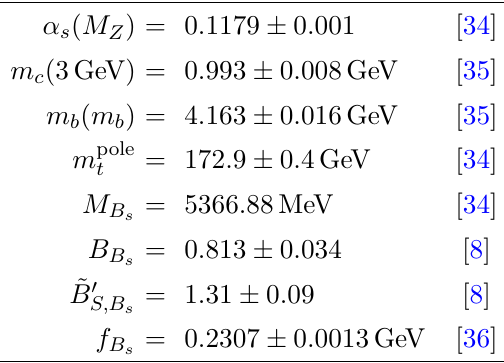
Table 2. Input parameters for the numerical analysis. From the charm and bottom quark mass one obtains ¯ z = 0 . 04974 ± 0 . 00092 . The quoted m pole the MS scheme. We use the values for B 4 . 56